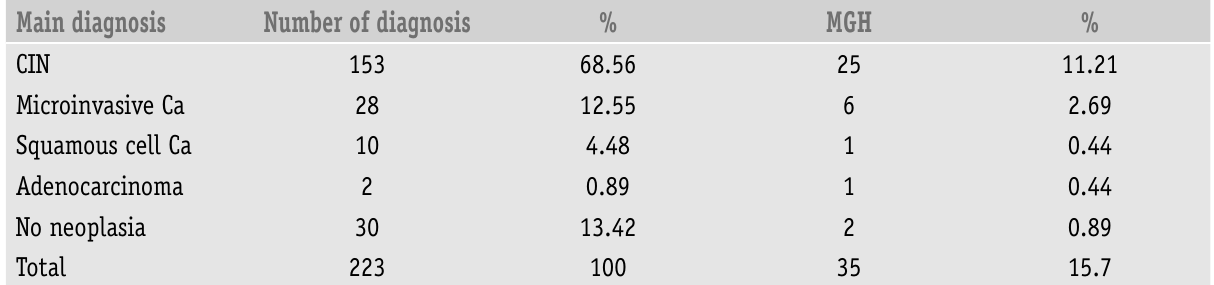
Cervical biopsies with the diagnosis of adenocarcinoma (ACa): histological types, grades and CEA, Ki67 and p53 expressions